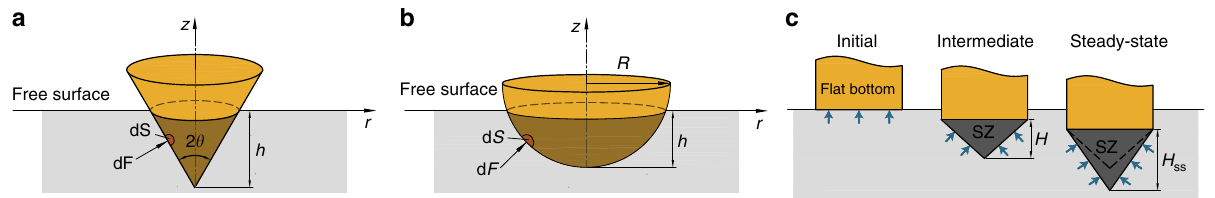
Fig. 6 Illustration of the non- fl at intruders and the growth of the SZ. a A conical intruder. b A semi-spherical intruder. c A sketch of the development of the SZ ahead of a fl at-bottom intruder. Note the change in the directions of the normal forces as the SZ evolves